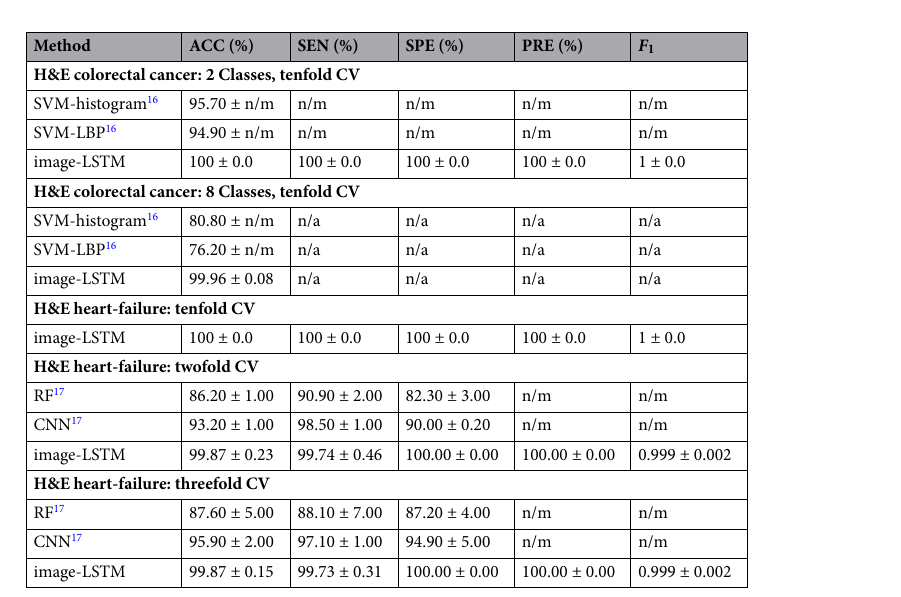
Table 1. Classification results. n/m not mentioned, n/a not